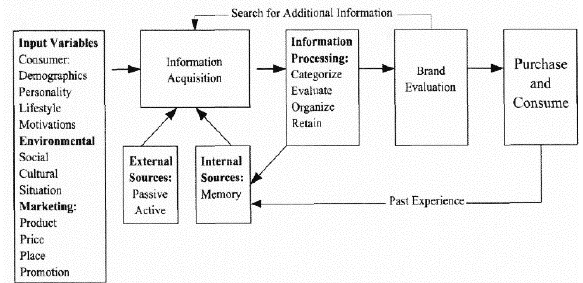
Figure 2. Assael’s Consumer Information Table 1. Stages of Assael’s Consu mer